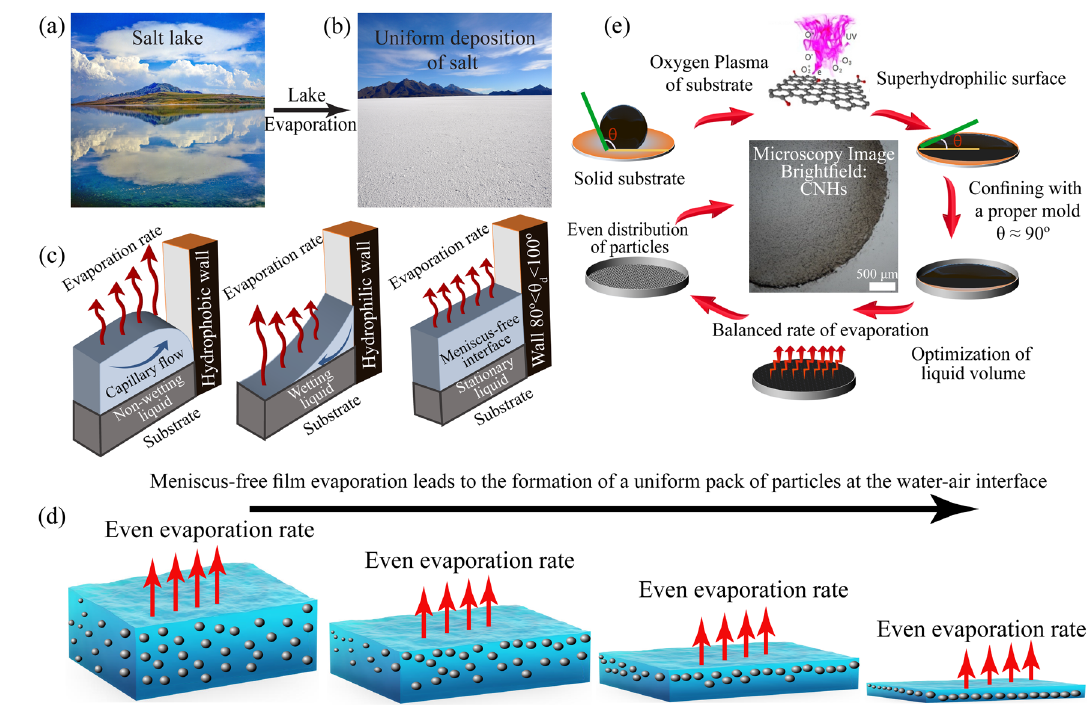
Fig. 1 Nature-inspired uniform salt fi lm formation in a salt lake. a A salt lake represents a large uniform fi lm with negligible curvature at the interface. b Salt deposited on the lake-bed after evaporation, showing a uniform coating. c The effect of the interface meniscus on the evaporation rate. For designs with a hydrophobic or hydrophilic interface meniscus, the closer the liquid-air interface is to the substrate, the higher the rate of evaporation and capillary fl ow. The meniscus-free interface of a mold with neutral wettability in our meniscus-free and coffee-ring-free protocol enables a coffee-ring-free particle deposition. d Meniscus-free fi lm evaporation causes a gradual particle deposition at the liquid/air interface without any capillary fl ow, leading to the formation of a uniform layer. e The proposed protocol suppresses the coffee-ring effect by employing an oxygen plasma for substrate treatment and a shadow mold with neutral